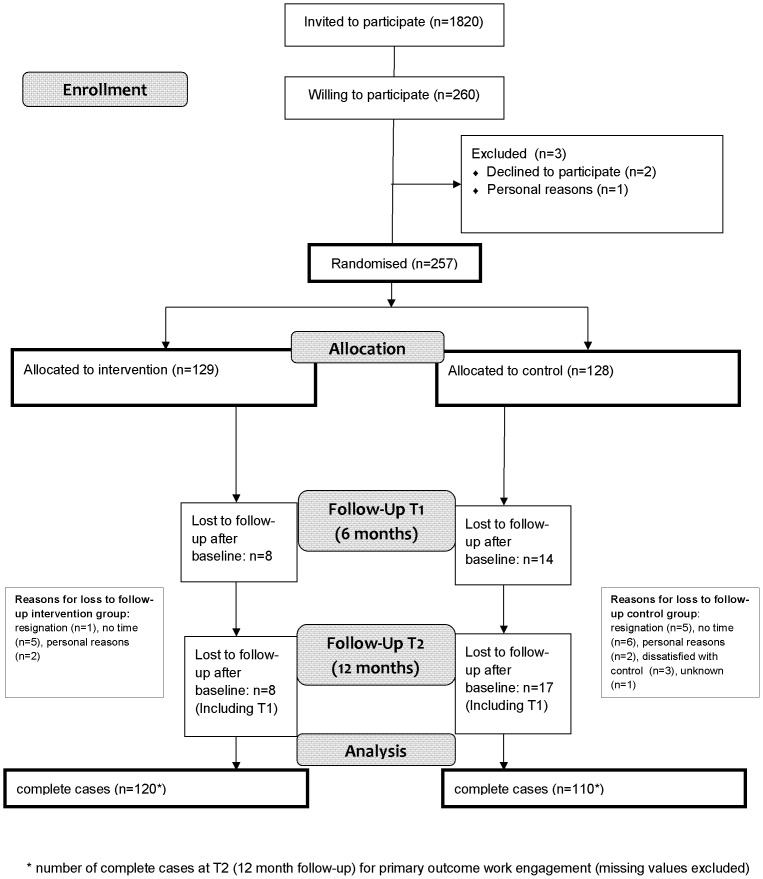
Flow Diagram Mindful VIP study.